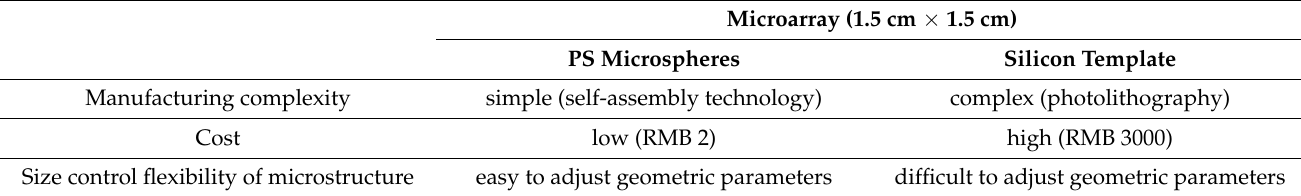
Table 2. Comparison of manufacturing complexity, cost, and flexibility in size control of PS